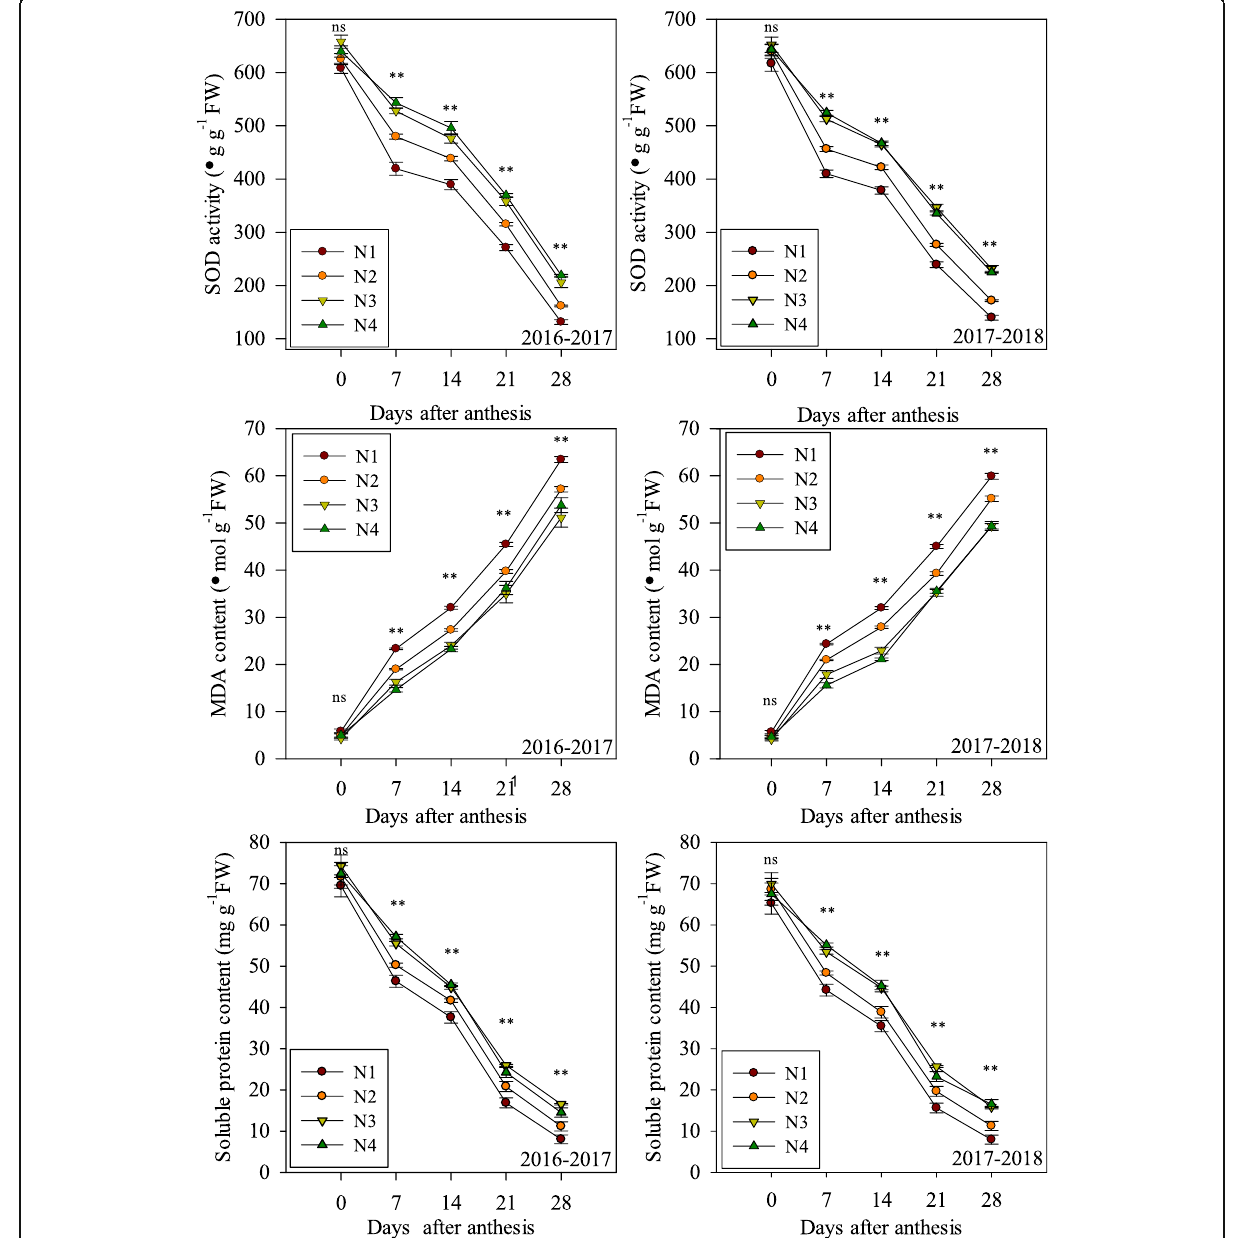
Fig. 3 Effects of four split nitrogen fertilizer treatments on flag leaf MDA content, SOD activity, and soluble protein content at 0 days, 7 days, 14 days, 21 days, and 28 days after anthesis. ns, not significant; ** P <0.01; * P